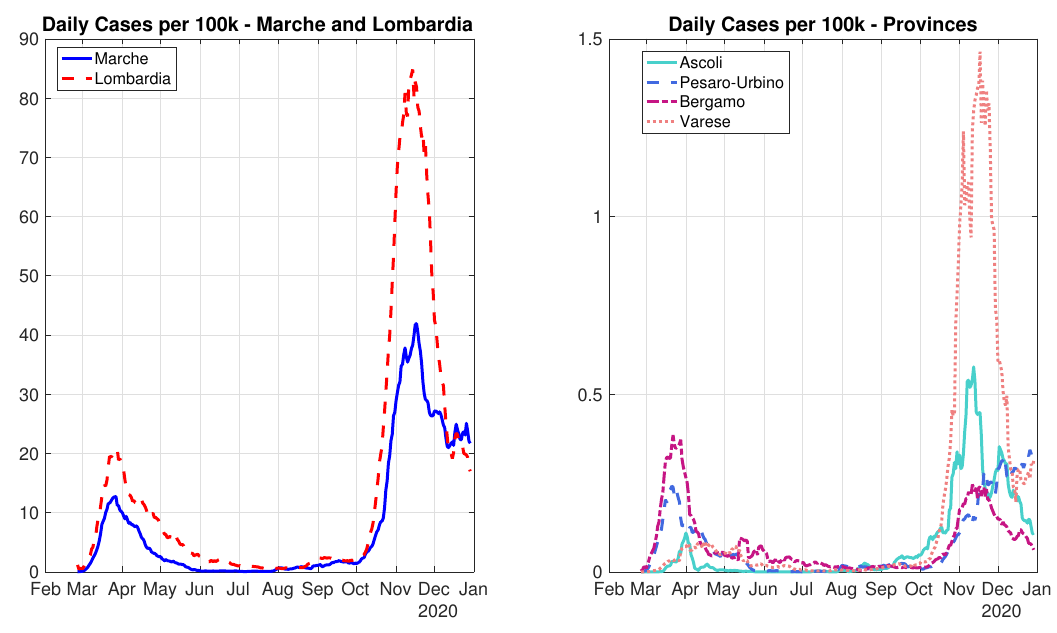
Figure 1. Daily cases per 100k people in Marche and Lombardia. Note: the left panel shows the evolution of daily COVID-19 cases per 100 thousand people in Marche (solid blue line) and Lombardia (dashed red line). The right panel displays the same variables for two provinces of Marche (Ascoli Piceno and Pesaro-Urbino, respectively, in light and dark blue lines) and of Lombardia (Varese and Bergamo, respectively, in light and dark red